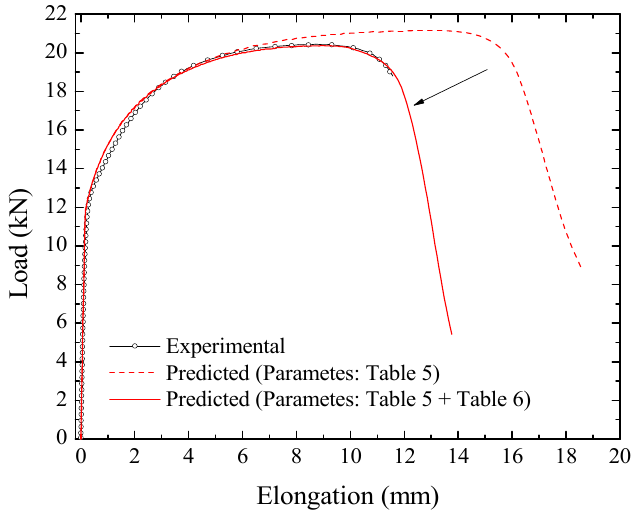
Figure 14. Experimental uniaxial tensile test load elongation and predicted results obtained with the fully dense matrix parameters (Table 5) and with the parameters of the fully dense matrix and the GTN parameters (Tables 5 and 6). Table 6. Initial porosity, material, and void nucleation